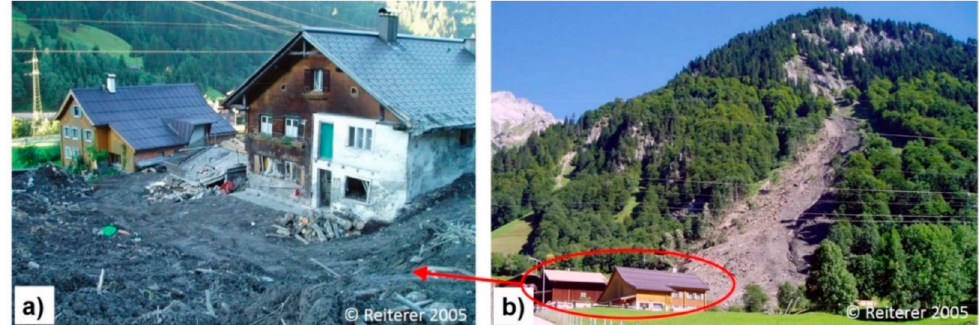
Figure 20. Details of the damages caused by the Danöfen earth flow ( a ); overview of the area affected by the landslide ( b